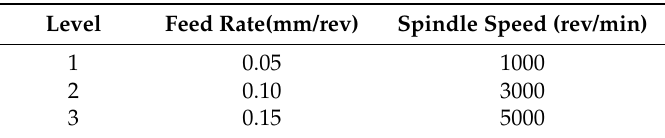
Table 3. Drilling parameters.